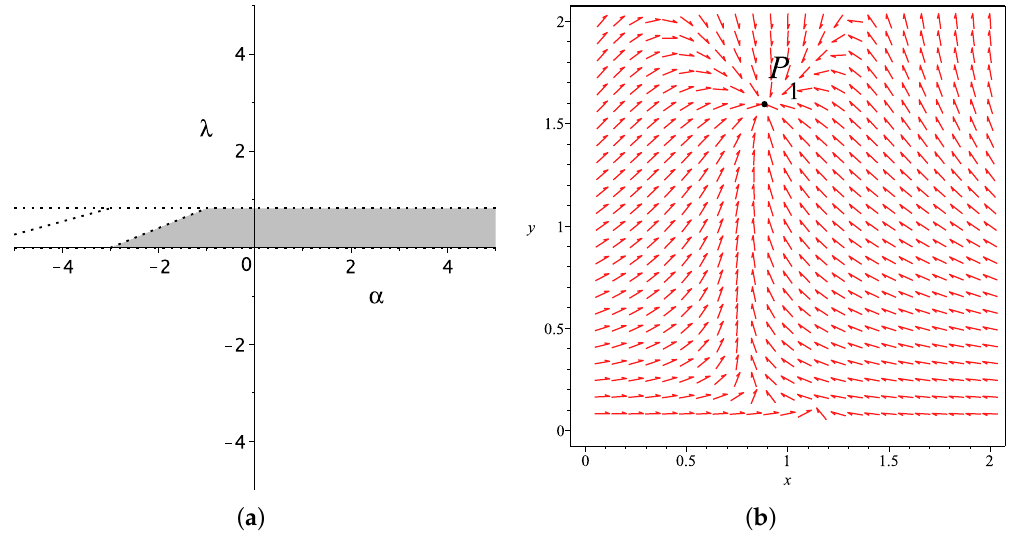
Figure 1. ( a ) The value ranges for parameters λ and α to make the critical point P 1 exist and stable, which is also constrained by other cosmological quantities, when x > 0. ( b ) The phase plane for λ = 0.5 and α = 0.01 around the attractor P 1 = ( 0.888,1.592 ) when x > 0.